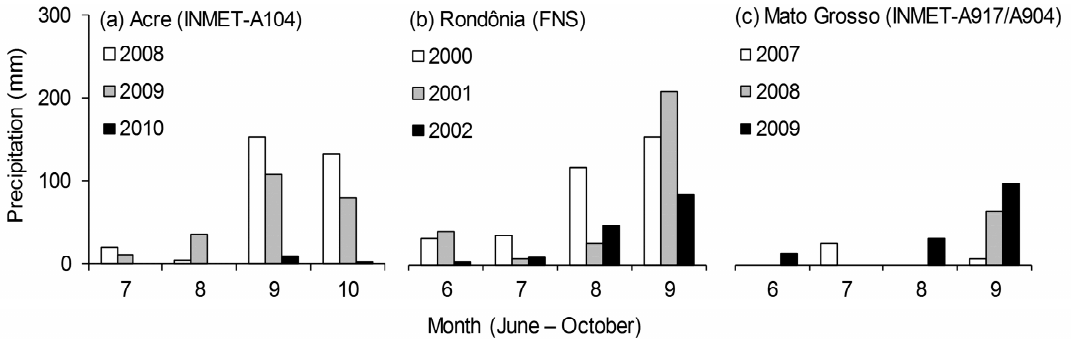
Figure 2. Rainfall measured at weather stations (Acre: INMET-A104, Rondônia: FNS, and Mato Grosso: INMET-A917/A904) during dry season months at three different study sites. Table 1. Summary of study site and weather station/flux tower information.